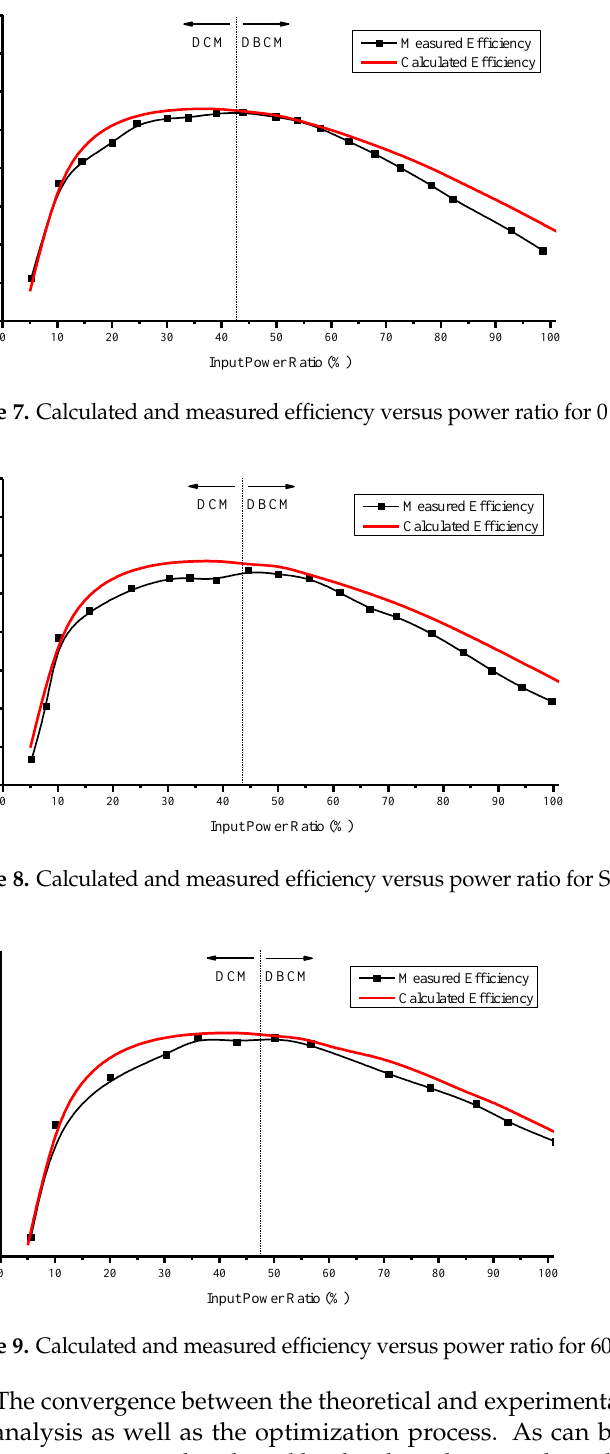
Energies 2021 , 14 , x FOR PEER REVIEW 11 of 20 Figure 6. Grid voltage and converter output current (100 V/div, 0.5 A/div, 10 ms/div, V dc = 40 V).